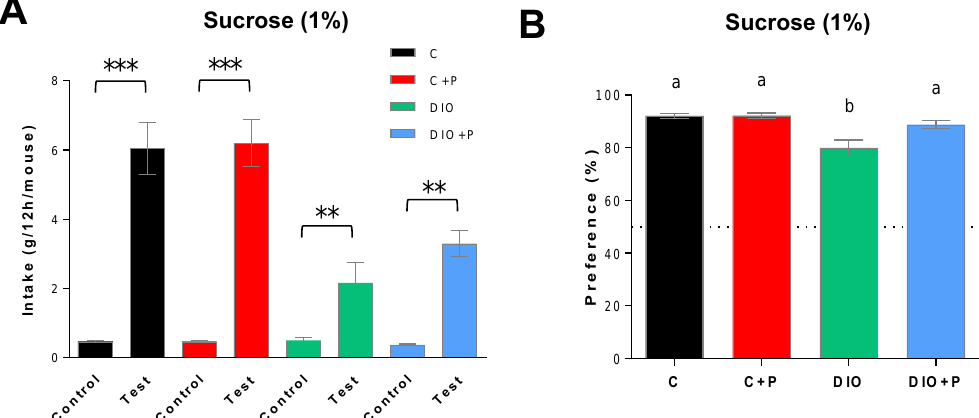
Figure 3. Two-bottle choice test analysis of orosensory perception of a sweet stimulus in mice subjected to a regulatory chow or an obesogenic diet alone (C and DIO) or supplemented with 10% Prebiotic (C+P and DIO+P). Animals were simultaneously subjected for 12 h to a control solution (0.3% xanthan gum in water, w / v ) and a test solution containing 1% sucrose ( w / v ) in the control solution. ( A ) Final consumption of control and experimental solution; ( B ) Preference i.e., ratio of the final consumption of control or experimental solution upon the final total liquid intake. Mean ± SEM. ( A ) Student t test: ** P < 0.01, *** P < 0.001; ( B ) 2-way ANOVA + Tukey HSD: different letters indicate a statistical difference between groups. Significance was achieved at p < 0.05. C, C+P, DIO, n = 10. DIO+P, n = 8. The dotted line represents the 50%